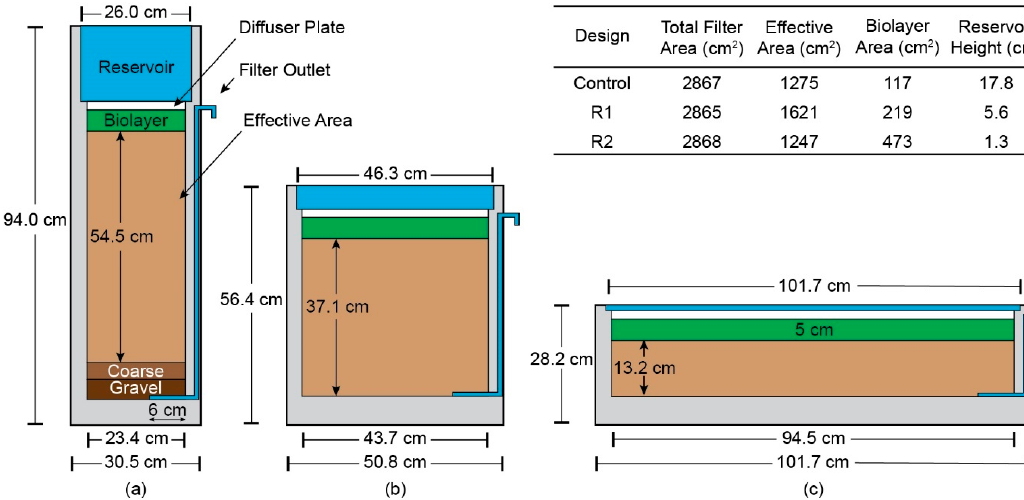
Figure 1. Visualizations and volumetric properties of ( a ) a traditional biosand water filter (BSF) design (control); ( b ) a 40% reduced-height design (R1); and ( c ) a 70% reduced-height design (R2).